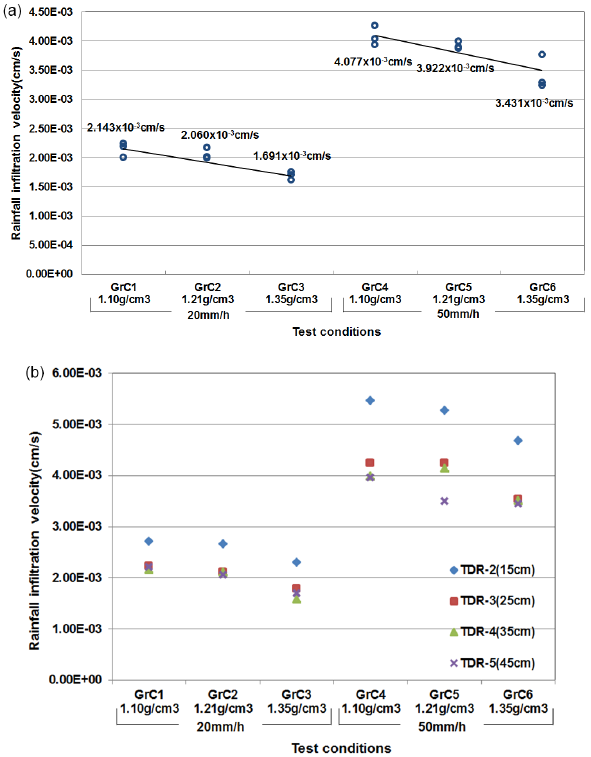
Figure 8. Rainfall infiltration velocity of the weathered granite soil under various conditions. (a) Rainfall infiltration velocity under each rainfall and unit weight soil condition and (b) rainfall infil- tration velocity at each